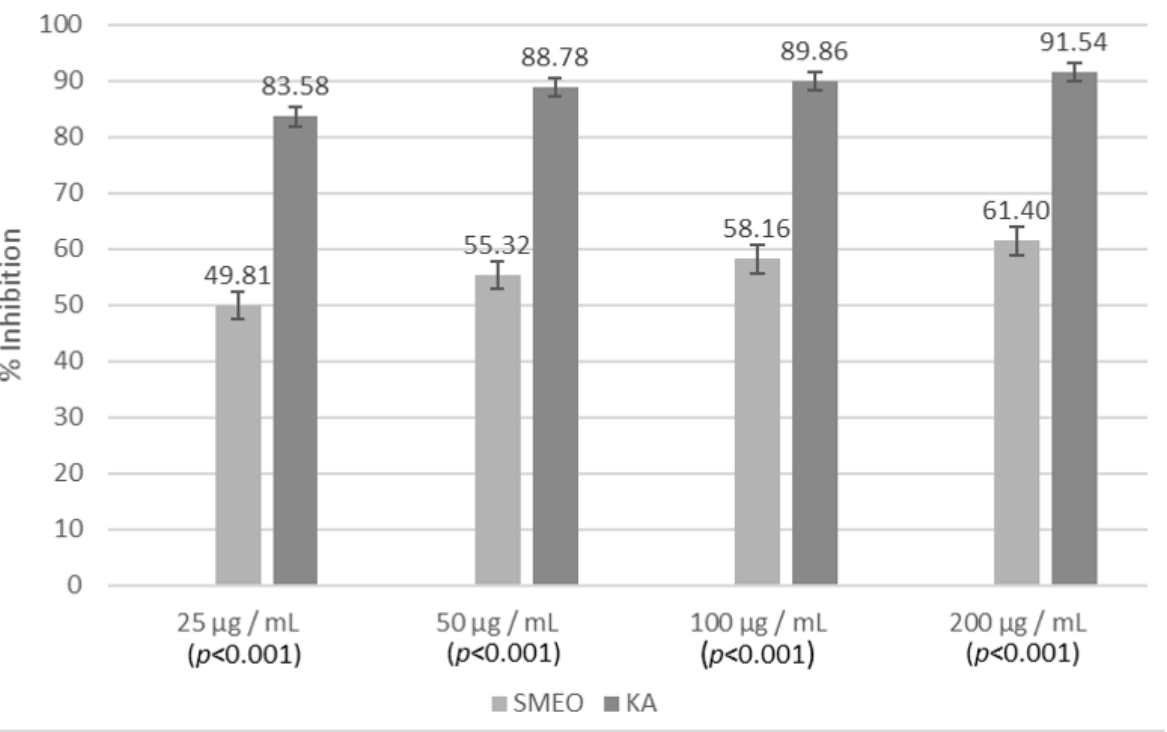
Figure 2. Tyrosinase inhibition activity of S. macrostachya, KA: Kojic acid (Positive control), % Inhibition: The percent inhibition in comparison with a control containing no inhibitor, n= 3, p: test statistics p value of independent samples t